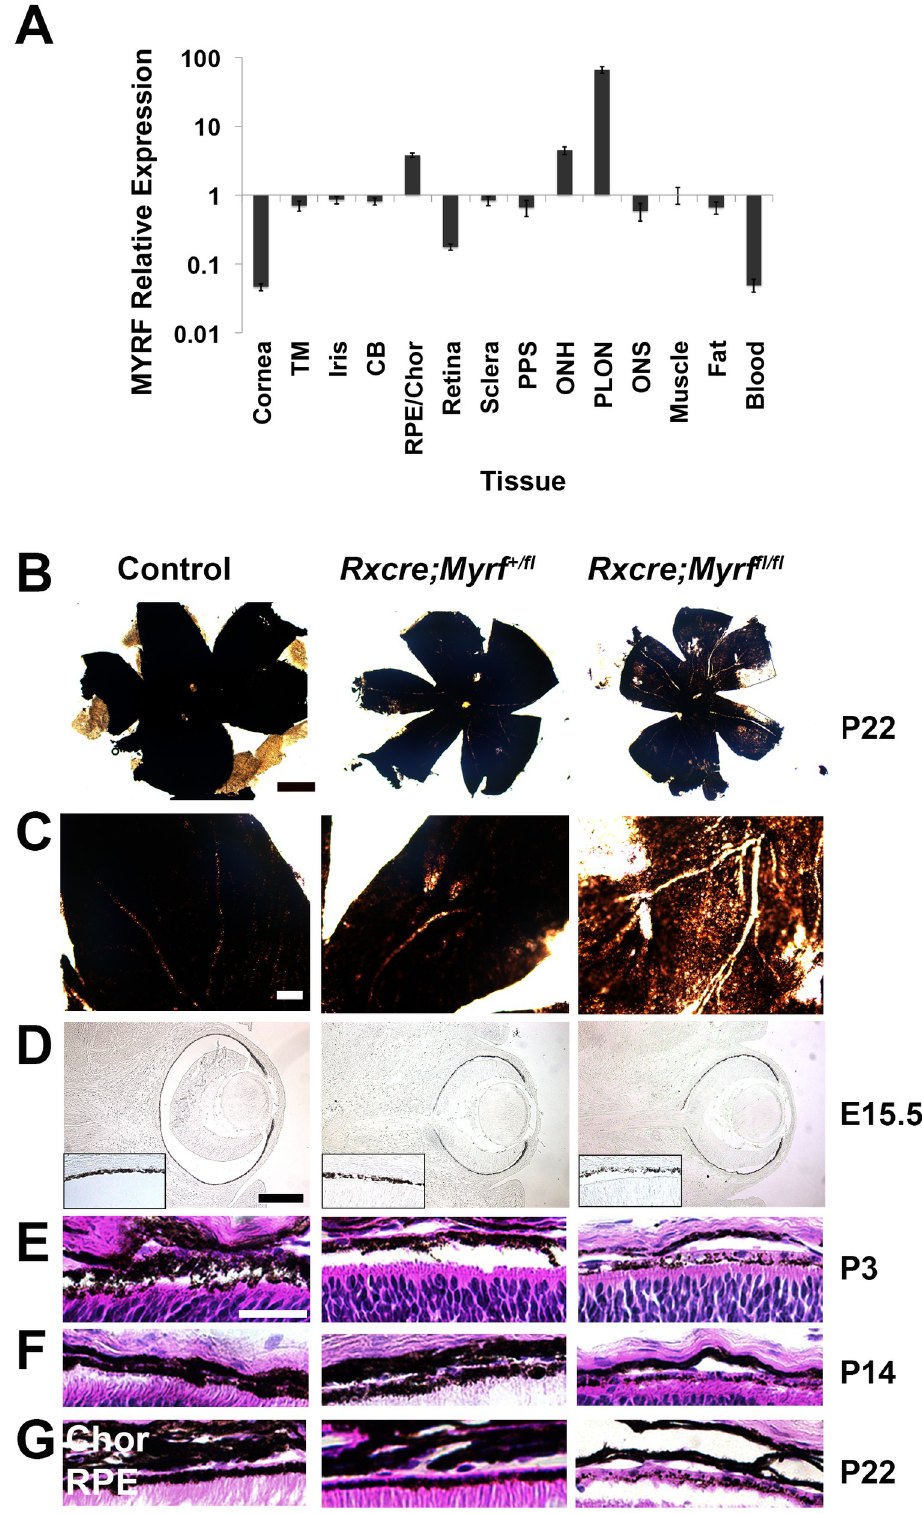
Fig 5. MYRF is expressed in the RPE and loss of MYRF in mouse leads to pigmentary change in the mouse RPE. (A) qRT-PCR showing relative expression of MYRF in human ocular and adnexal tissue. MYRF expression